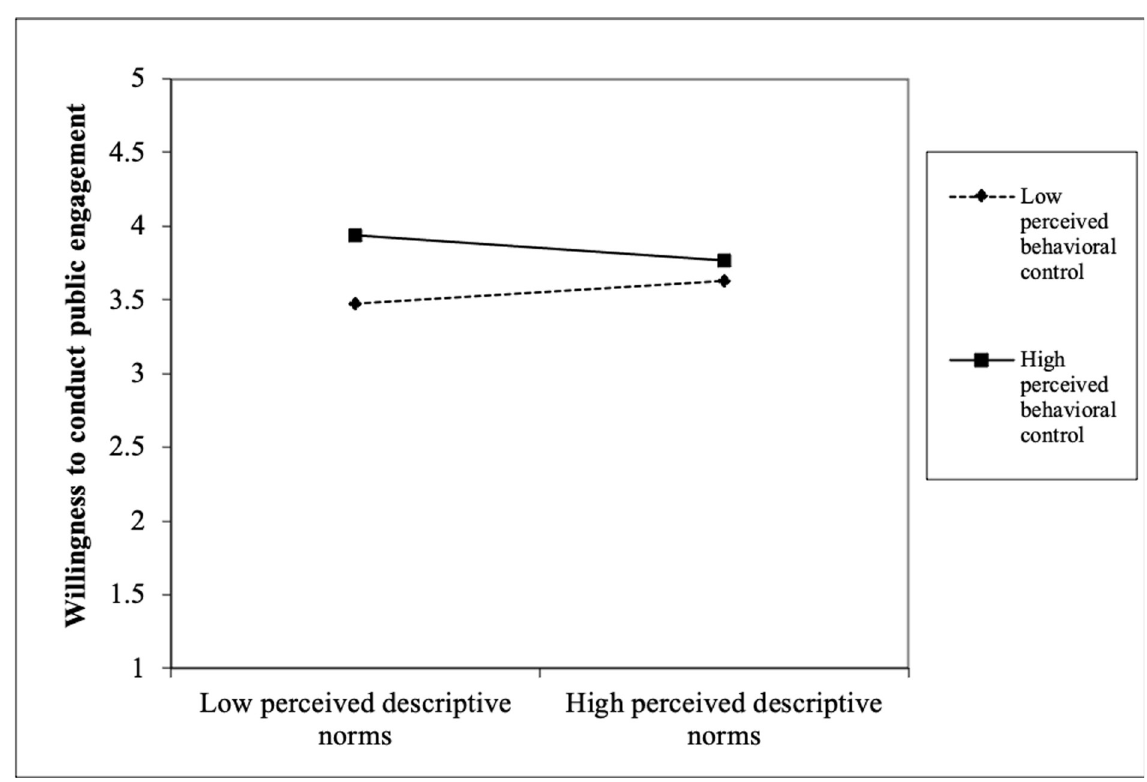
Fig 2. Perceived behavioral control as a moderator of the perceived descriptive norms-willingness